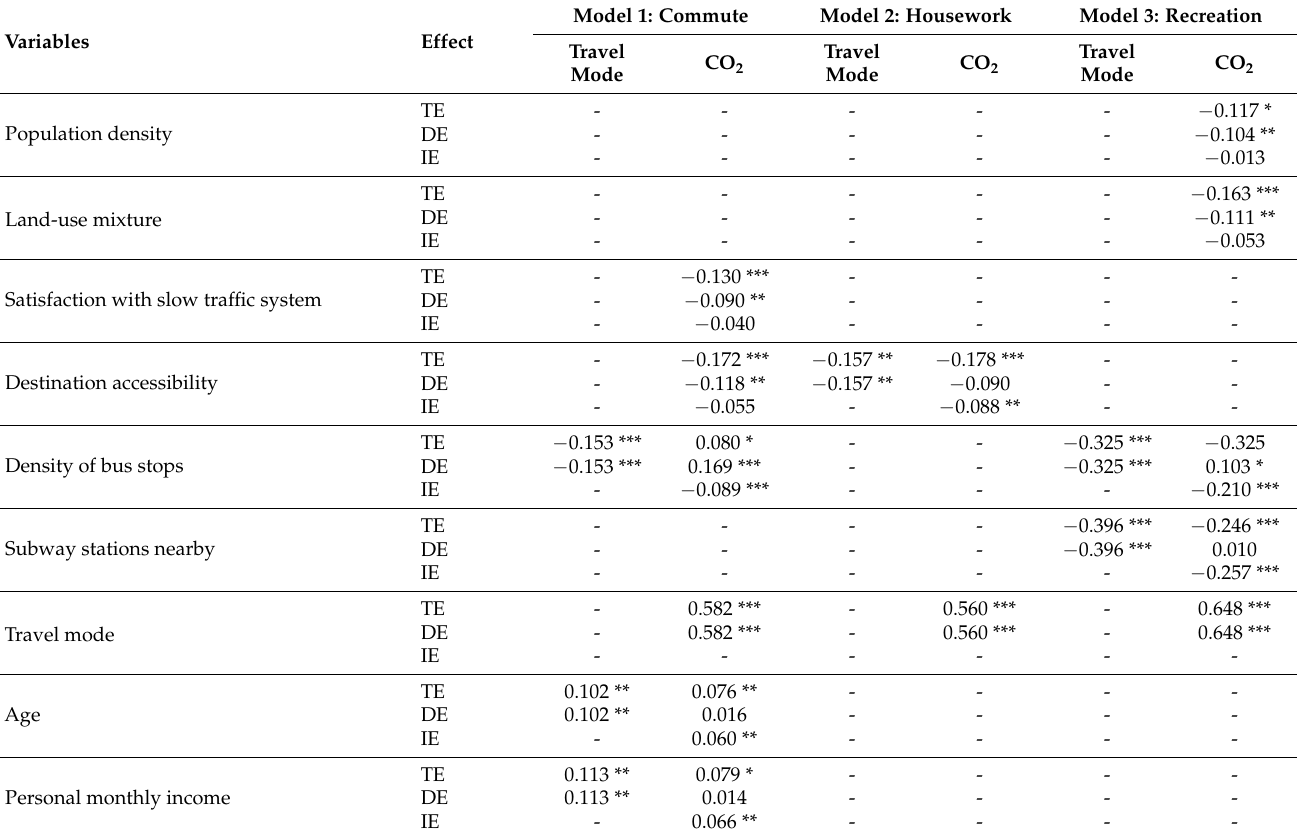
Table 7. Standardized direct and total effects of three models.